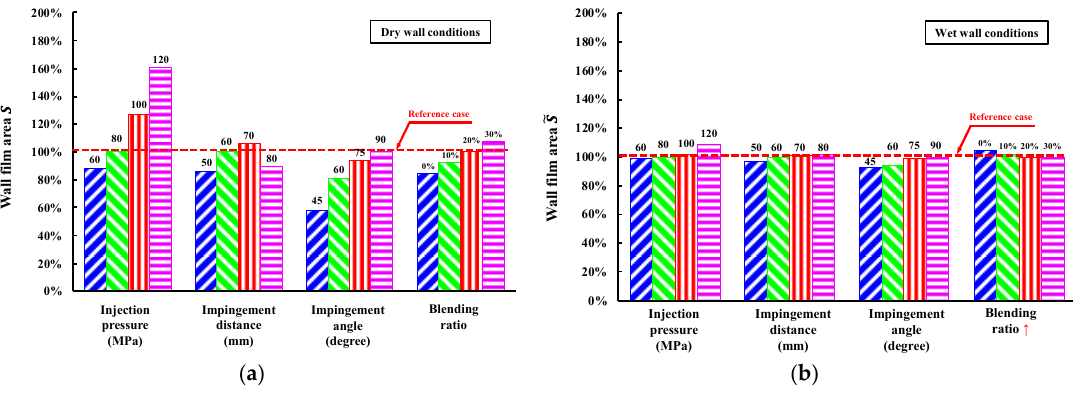
Figure 9. Variations of wall film area under different experiment conditions for: ( a ) dry wall conditions; and ( b ) wet wall conditions.